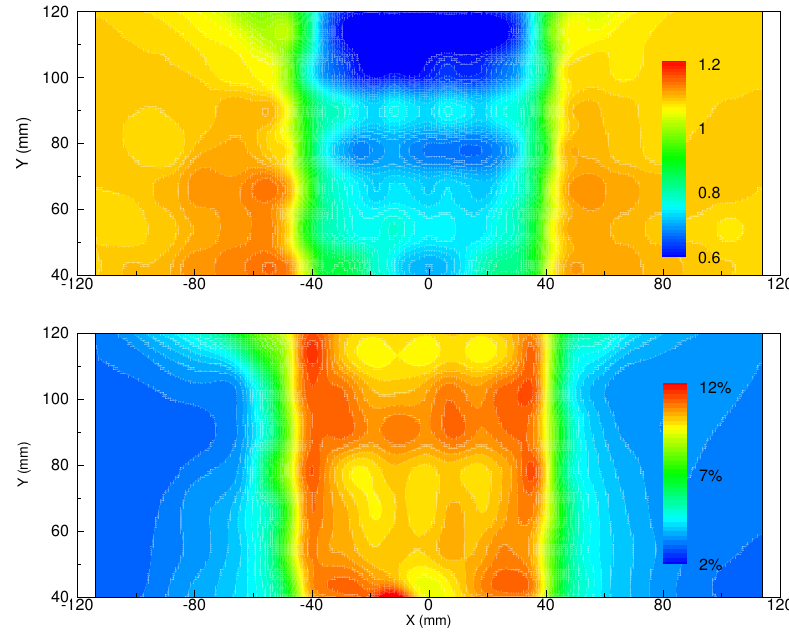
Figure 3. Non-uniform wake: mean velocity field normalized by the upstream flow velocity ( top ); velocity fluctuations as a percentage of upstream flow velocity ( bottom ). The propeller axis is at